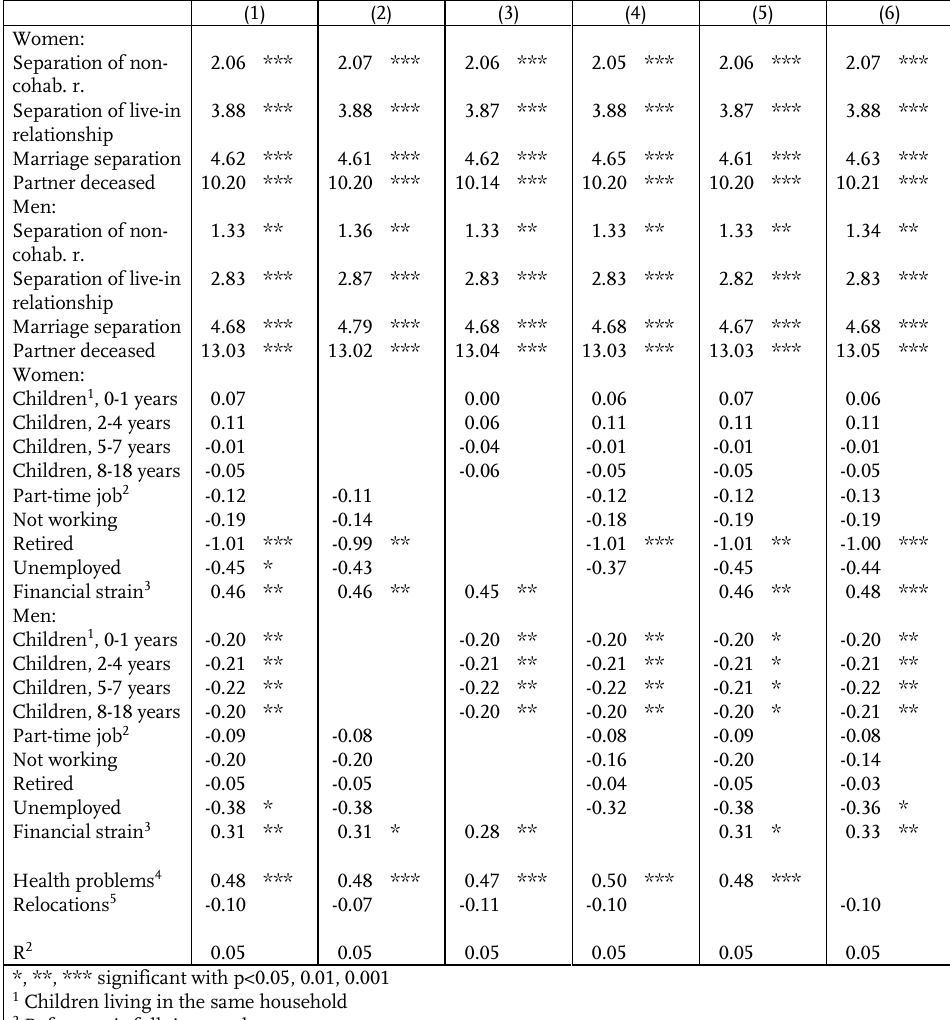
Table A.11 : Effects of relationship endings, children, employment, financial strain, relocations, and health on isolation from all social spheres (linear-probability models with fixed effects, percentage